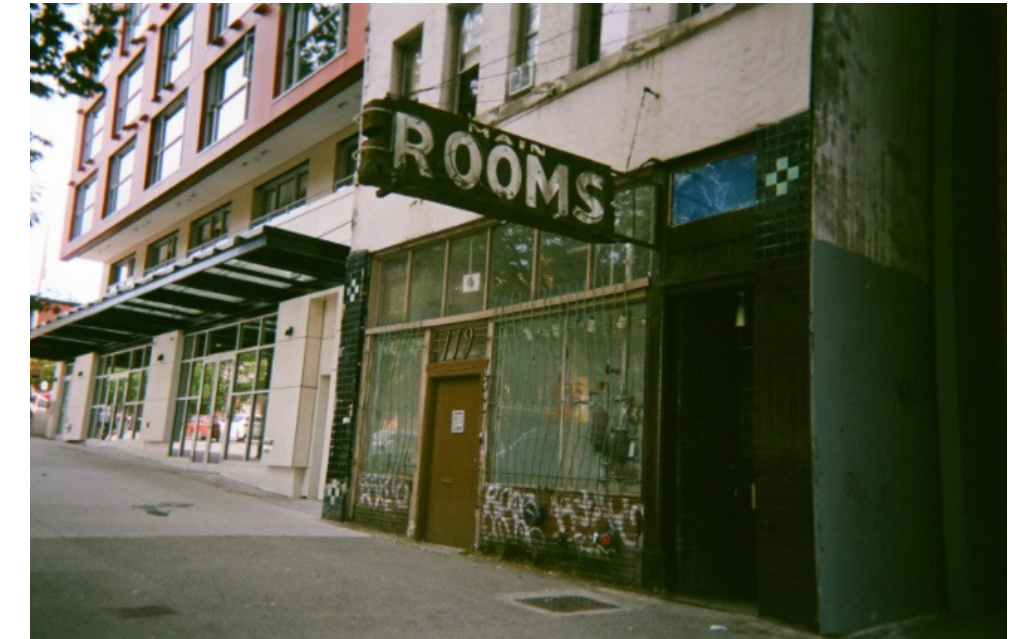
Figure 4. SRO housing. Source: Photo credits, Juan. and community meal programmes. One long‐term resi‐ dent expressed his concerns: Downtown Eastside, a dart in the heart of gentrifi‐ cation, exploitation, incompetence, marginalization, where poverty, mental illness, and social injustice are rising up, without having a solution from those who are supposed to help to improve local residents’ lives.